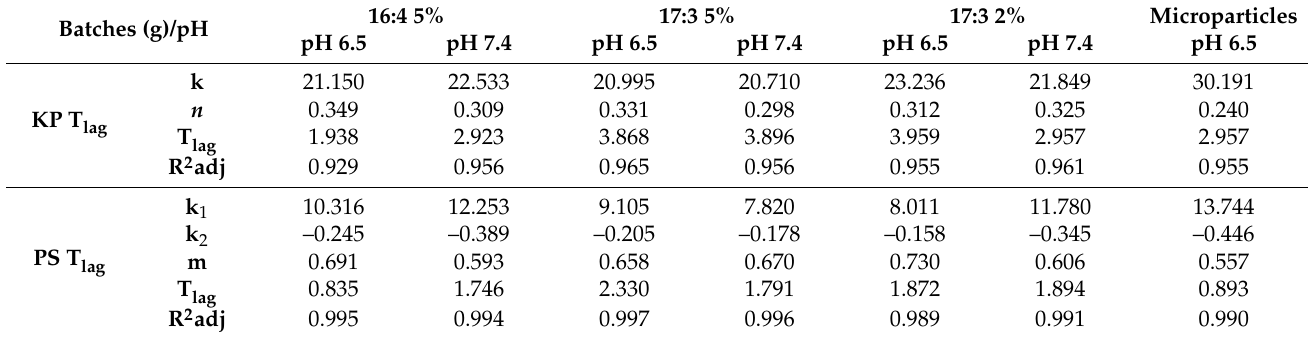
Table 2. Parameters obtained from the drug-release